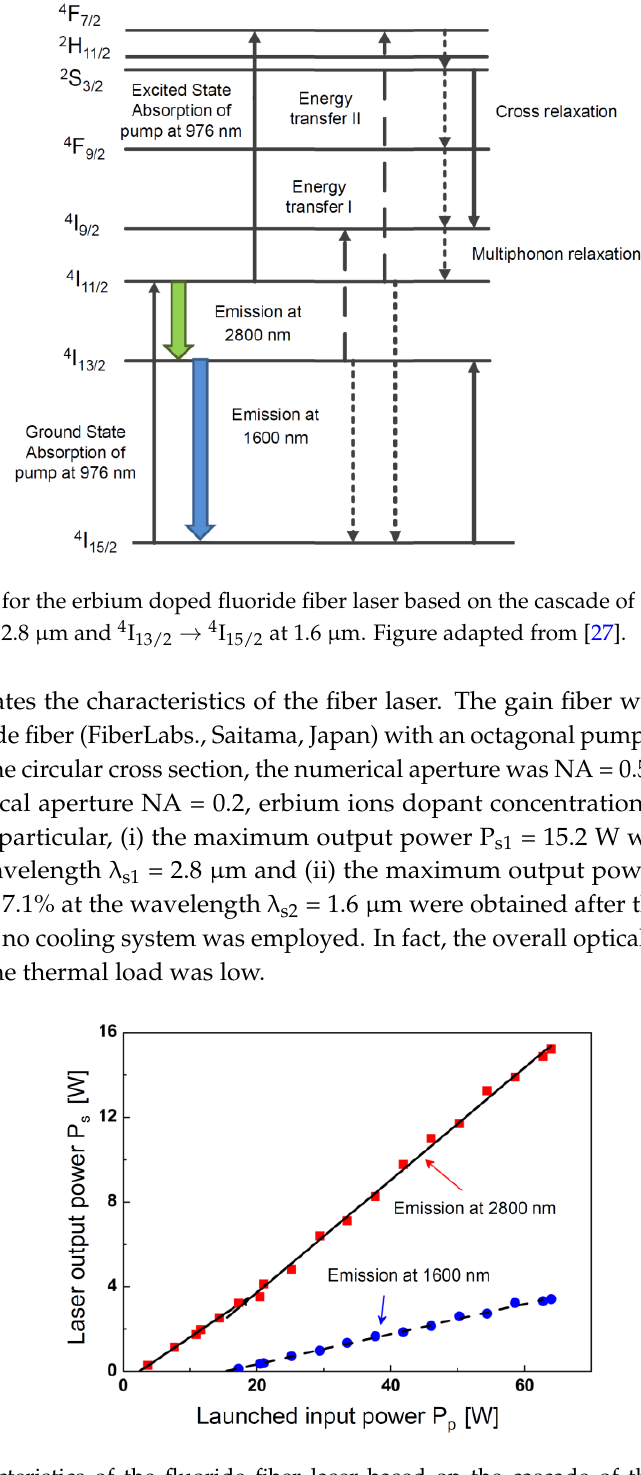
Figure 7. Characteristics of the fluoride fiber laser based on the cascade of the two transitions 4 I 11/2 → 4 I 13/2 at 2.8 μm and 4 I 13/2 → 4 I 15/2 at 1.6 μm. Figure adapted from [27].